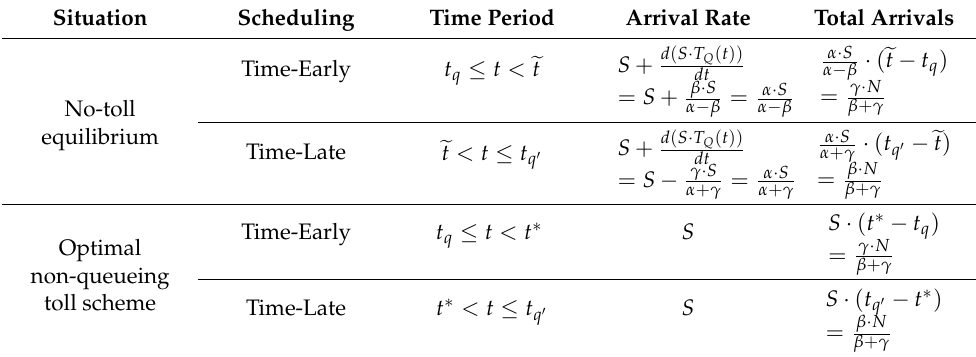
Table 4. Arrival rates and total arrivals before and after implementing the optimal non-queueing toll scheme.